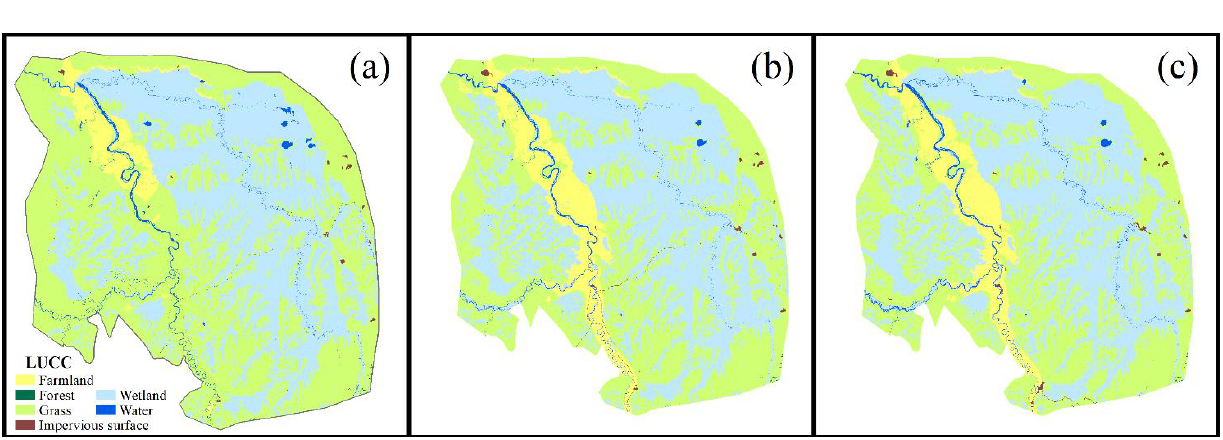
Figure A5. LUCC of Zoige region. ( a ) 2000, ( b ) 2010, and ( c ) 2019.